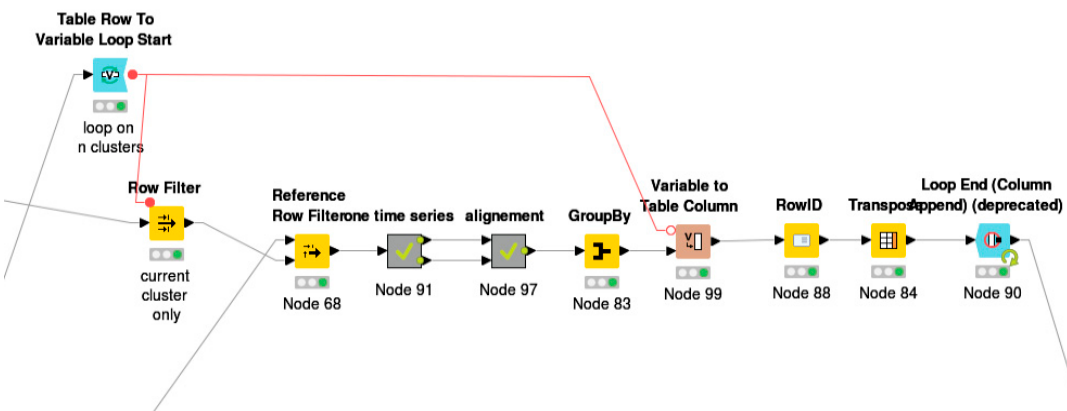
Figure 4. Sub workflow for time series Meta node.